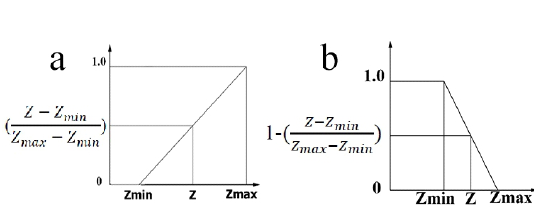
Fig. 5: Equation and diagram of fuzzy membership function; a) increasing linear and b) decreasing linear (Liu et al ., 2014)